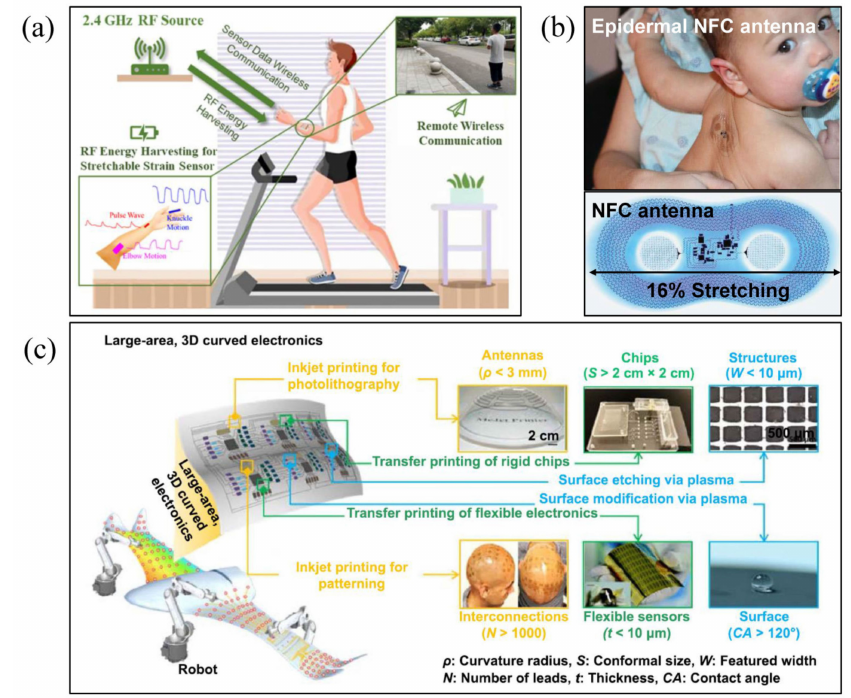
Figure 1. Application requirements of reconfigurable, flexible RF devices in flexible conformal elec- tronics. ( a ) The concept of a scalable RF system is to communicate wirelessly with the body [10], Reprinted/adapted with permission from Ref. [10]. 2022, Elsevier. ( b ) An NFC antenna for neonatal monitoring, which can be attached to areas of large skin deformation that result from wrinkling